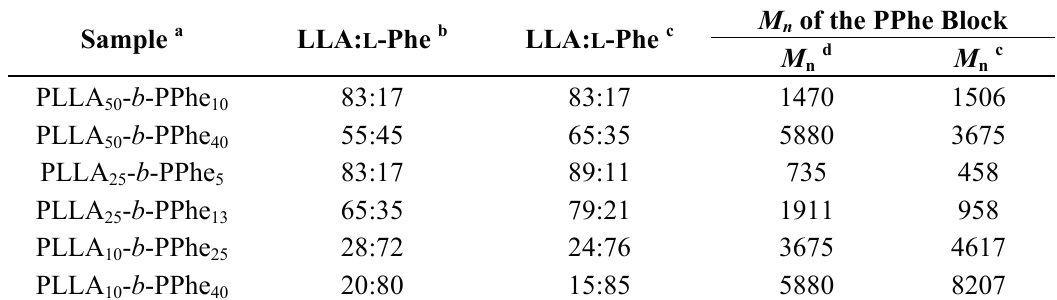
Table 2. Molecular weight characterization of block PLLA- b -PPhe copolymers.